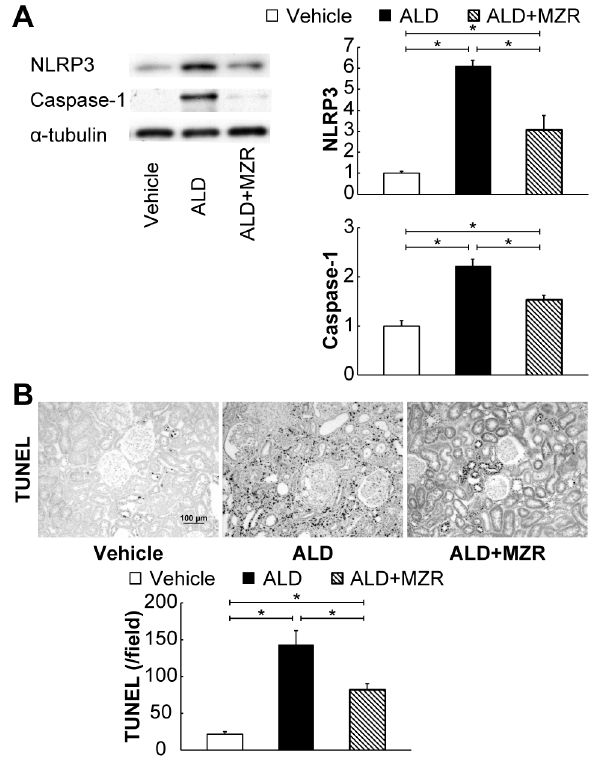
Figure 3. Mizoribine suppresses aldosterone-induced renal pyroptosis. Aldosterone (ALD) enhanced the renal expression of the nucleotide-binding oligomerization domain, leucine-rich repeat and pyrin domain containing (NLRP) 3 and caspase-1, and increased the number of TUNEL-positive cells—the hallmark of pyroptosis—whereas the increase in these factors was significantly suppressed by mizoribine (MZR). (A) Western blot analysis for NLRP3; caspase-1; and a -tubulin was performed. The total cell lysate was prepared from the rat kidney cortex. Graphs show the expression level quantified by densitometry and normalized with a -tubulin. (B) Representative photomicrographs of TUNEL staining of kidney sections. The graph shows the quantification of TUNEL-positive cells. Values are presented as mean 6 SEM. * P , 0.05.